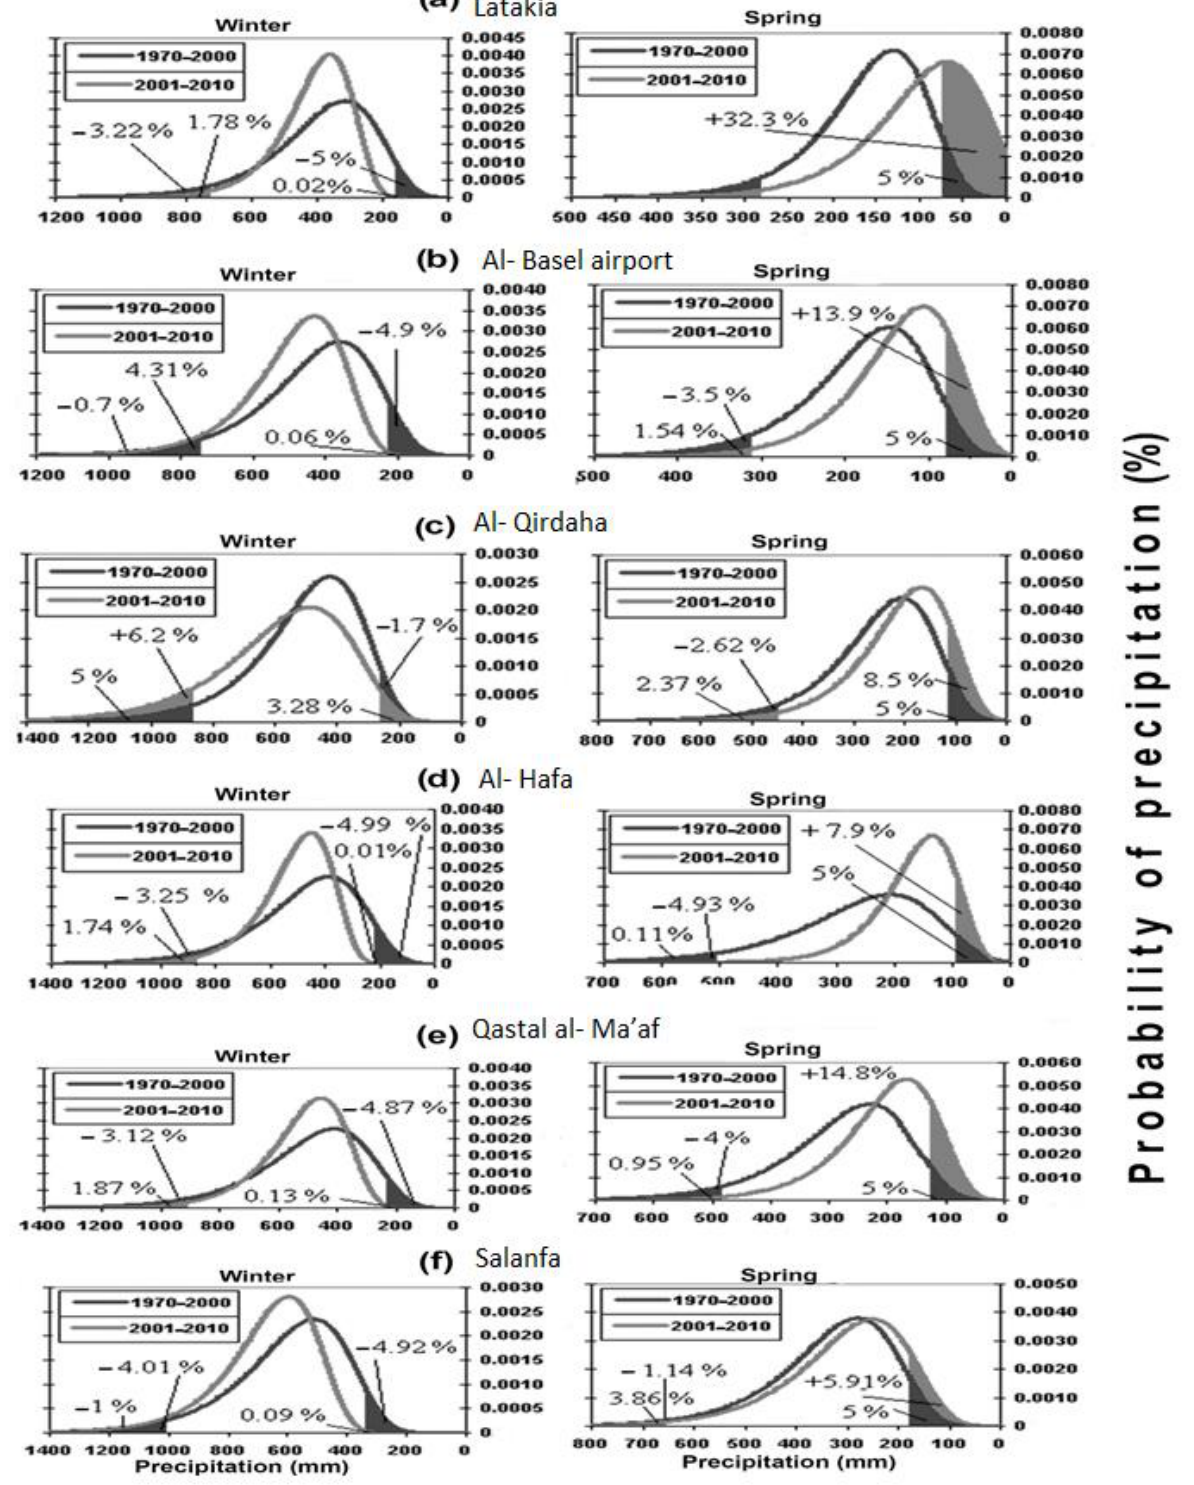
Figure 5. Changes in the potential probability of the annual average precipitation during spring and winter seasons in both time-periods. ( a ) Latakia; ( b ) Al- Basel airport; ( c ) Al- Qirdaha; ( d ) Al- Hafa; ( e ) Qastal al- Ma’af; ( f ) Salanfa.